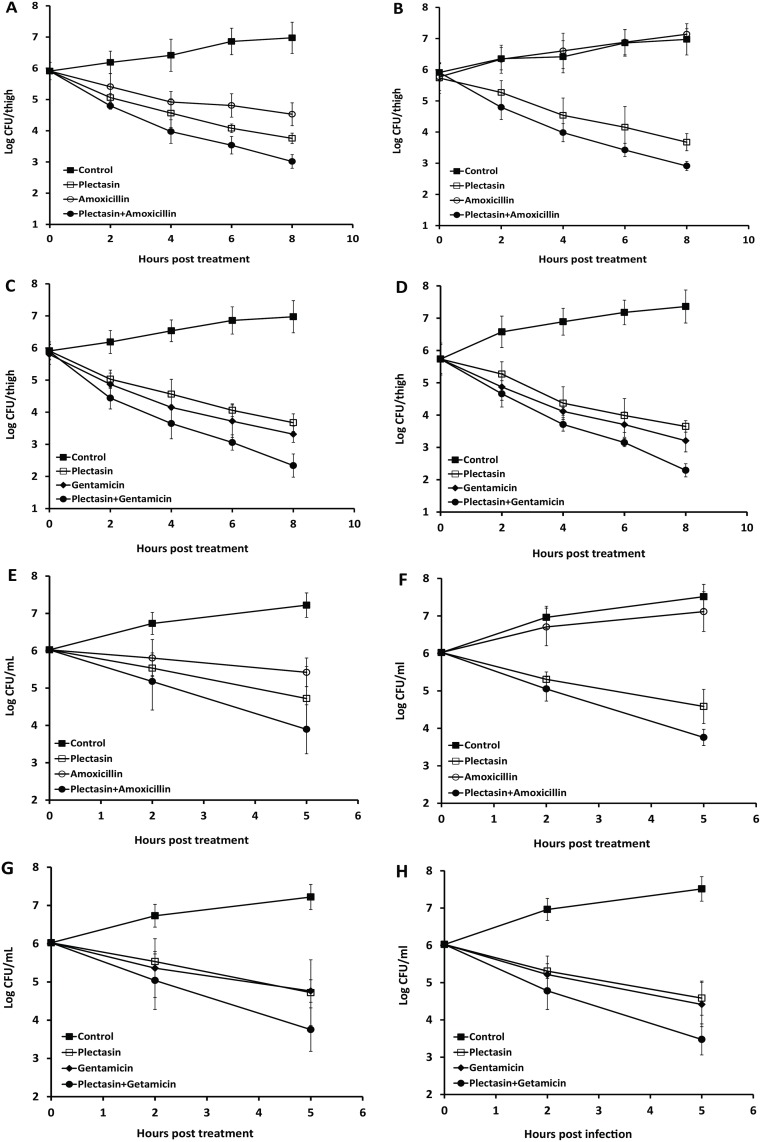
Effects of plectasin in combination with amoxicillin and gentamicin against MSSA and MRSA in a murine thigh infection model and in a mouse peritoneal infection model.In the murine thigh model, mice were infected with a strain of MSSA (t021) and a strain of MRSA (t032). Treatment was initiated 2 hours after infection with plectasin and amoxicillin against MSSA (A) and MRSA (B) and with plectasin and gentamicin against MSSA (C) and MRSA (D). Viability of the bacterial cells was determined from 6 mice for each group at 2, 4, 6 and 8 hours after treatment. In the mouse peritoneal infection model, mice were infected with the same strain of MSSA or MRSA. One hour after infection, treatment was initiated with plectasin and amoxicillin for MSSA (E) and for MRSA (F) and with plectasin and gentamicin for MSSA (G) and for MRSA (H). Bacterial counts in the peritoneal cavity were determined from 4 mice for each group at 2 and 5 hours post-treatment. The data have been repeated once.